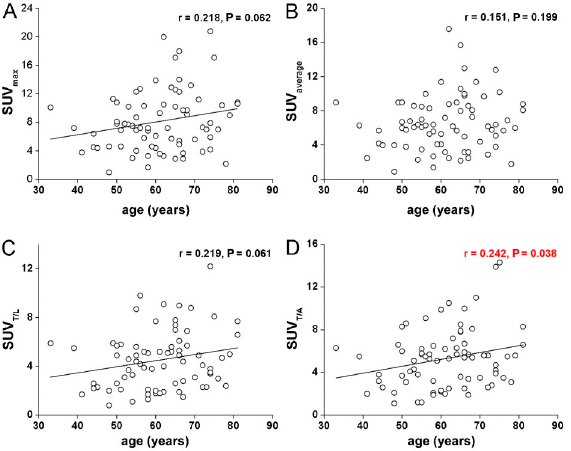
Figure 2. Correlation analyses between tumor size and standardized uptake values (SUVs). SUV max : maximum SUV; SUV avg : average SUV; SUV T/L : ratio of tumor SUV max to liver SUV; SUV T/A : ratio of tumor SUV max to the blood pool SUV of